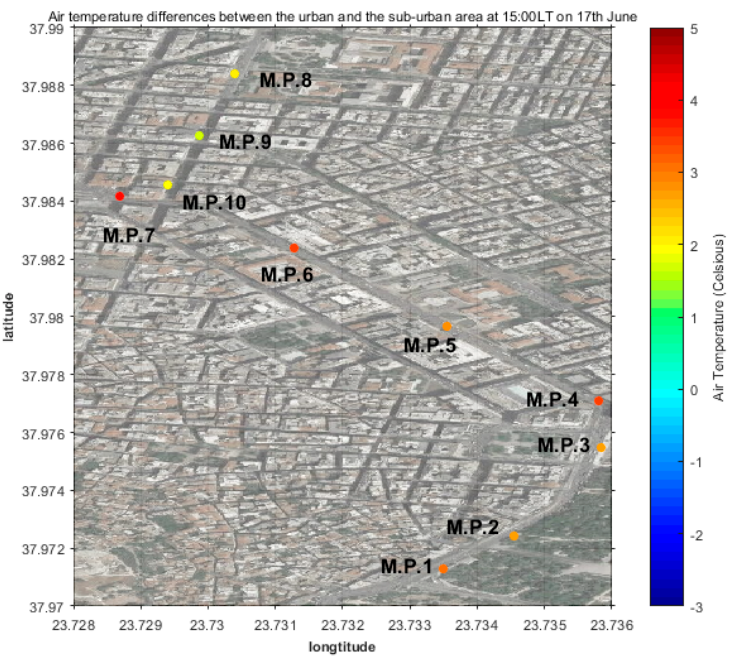
Figure 6. Air temperature differences between the ones recorded in the center of Athens at 15:00LT and the ones in the suburban station, during the 17th June.